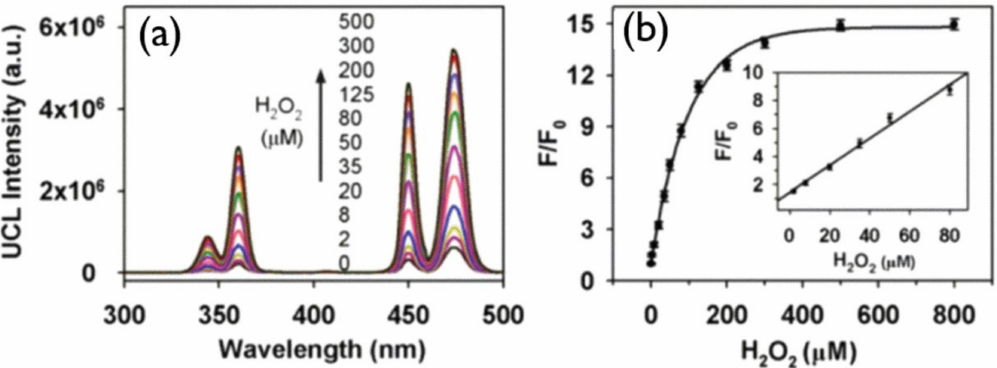
Figure 9. ( a ) Upconversion spectrum of DNA-AgNPs/UCNP at various concentrations of H 2 O 2 . ( b ) 450 nm emission enhancement (F/F 0 ) on increasing the amount of H 2 O 2 in DNA-AgNPs/UCNP; F and F 0 correspond to the upconversion emission intensity in the presence or absence of H 2 O 2 , respectively, in the system. Adapted with permission from